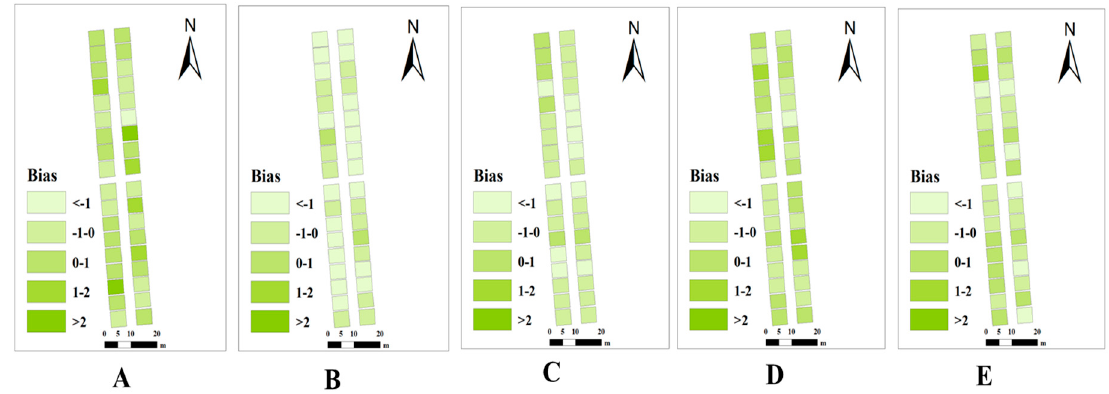
Figure 5. Bias mapping of LAI between measured and predicted values. ( A ) Jointing stage, ( B ) Booting stage, ( C ) Heading stage, ( D ) Anthesis stage, ( E ) Grain filling stage.